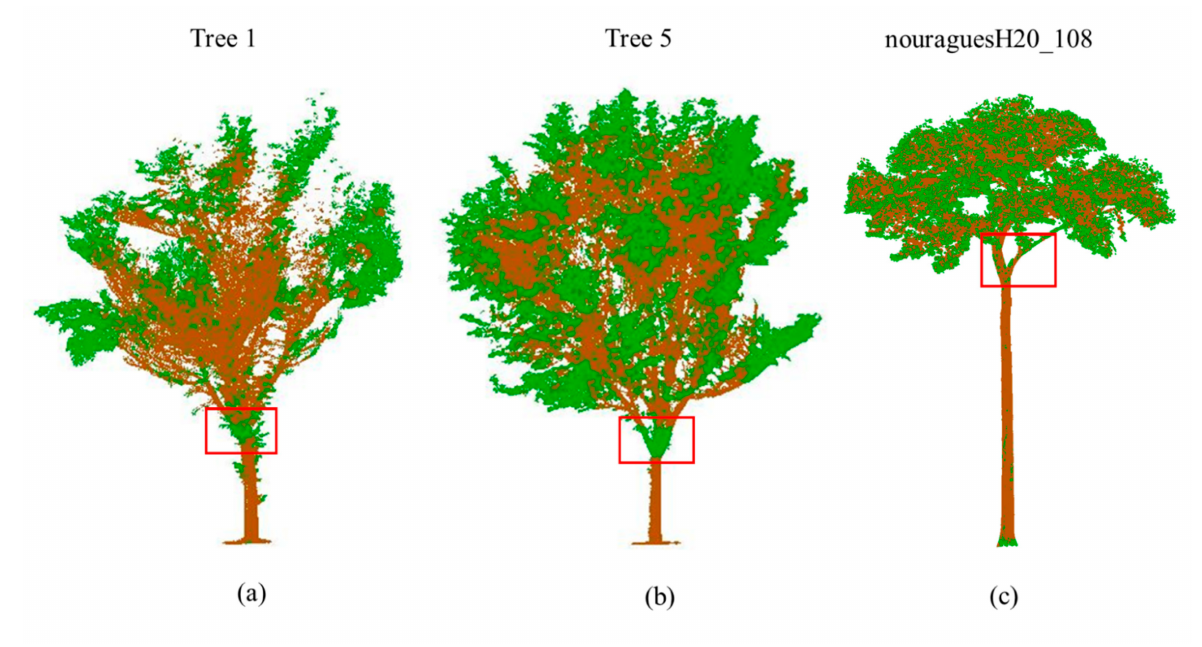
Figure 6. The multivariable time series (MTS) model of fully convolutional networks (FCN) prediction for Tree 1 ( a ), Tree 5 ( b ), and nouraguesH20_108 ( c ); the red square highlights the misclassified areas. Green: leaf points. Brown: woody points.